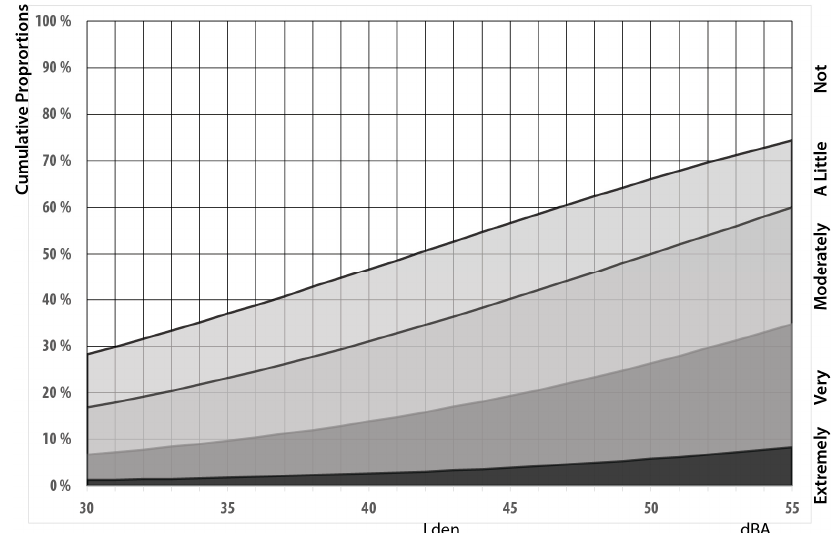
Figure 11. Exposure–effect relationships for people who are annoyed at outside dwelling as a function of L den . Curves for respondents who see one windmill, but don’t regard windmills as degrading the visual landscape. n = 87.